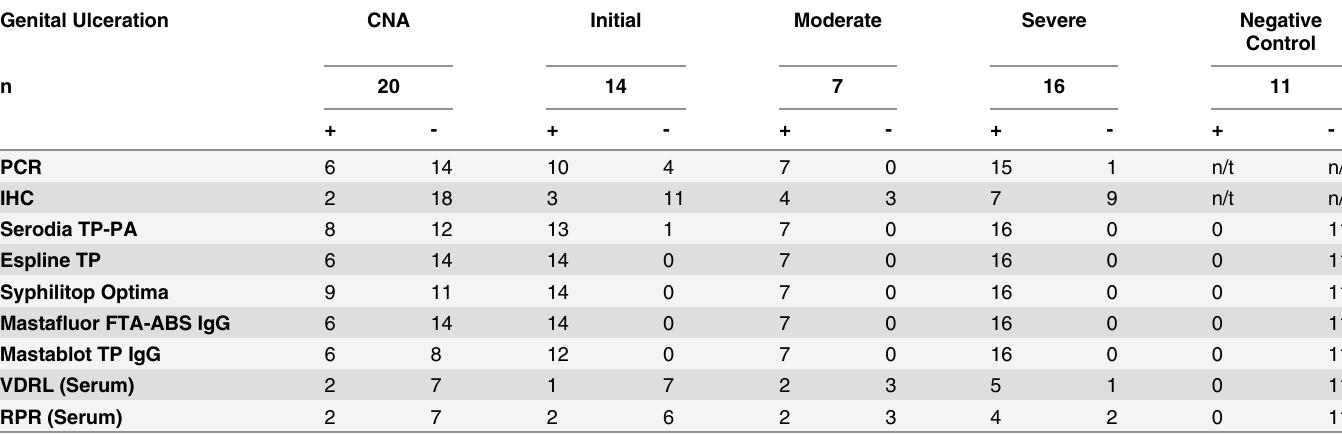
Table 5. Crosstab of the results obtained from 57 baboon and 11 control samples. Genital